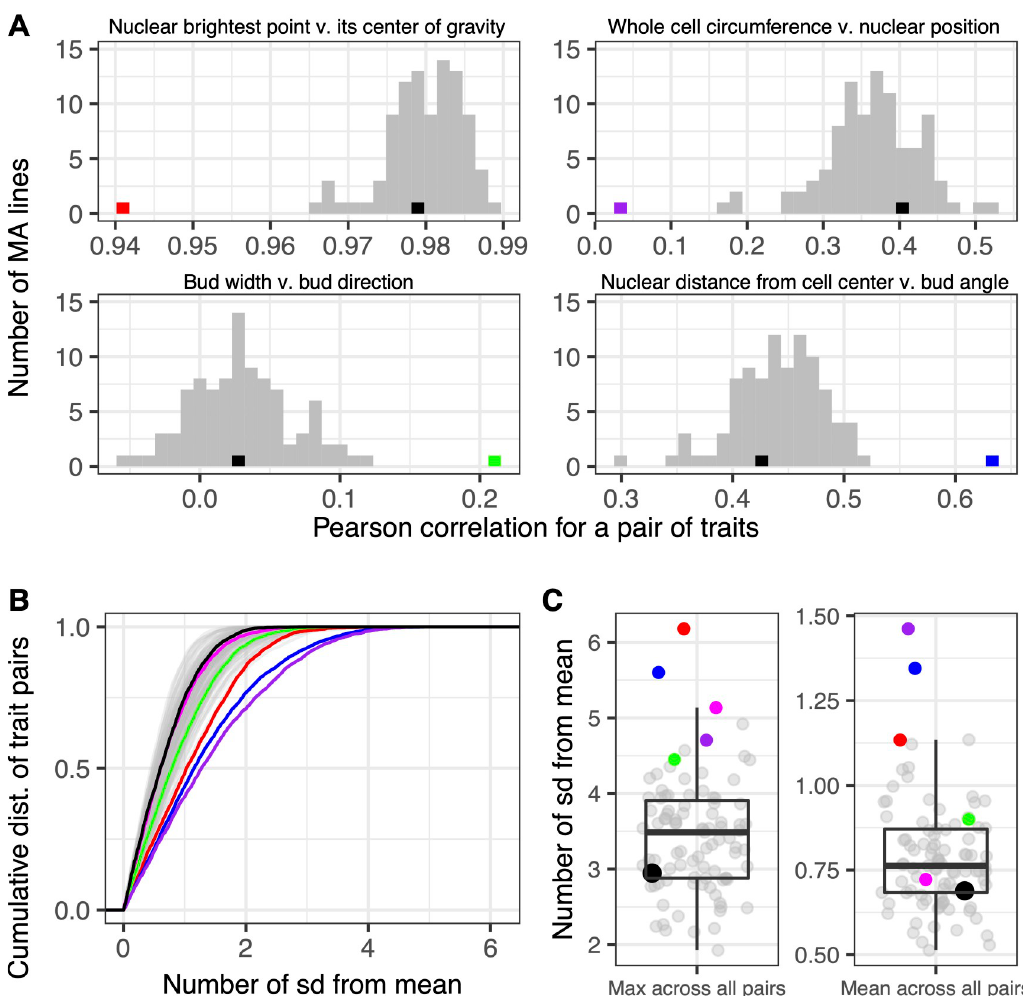
Fig 6. Some MA lines display unique relationships between certain pairs of traits. In all plots, black represents the ancestor of the MA lines and colors represent MA lines with trait correlations that differ from other lines (strains: black = HAncestor, green = DHC81H1, red = DHC41H1, magenta = DHC40H1, blue = DHC66H1, purple = DHC84H1; see S2 Table in [51]). (A) Histograms display the number of MA lines with Pearson correlations corresponding to the values on the horizontal axis for four example pairs of traits; the number of bins is set to 30. (B) This plot displays, for each of the 94 MA lines, the cumulative distribution (“dist.”) of the number of sd away from the mean correlation across all trait pairs. (C) Plots display, for each MA line, the maximum deviation from the mean observed for any pair of traits (left) and the average sd observed across all pairs of traits (right). Data underlying this figure can be found at https://osf.io/b7ny5/. MA, mutation-accumulation; sd, standard